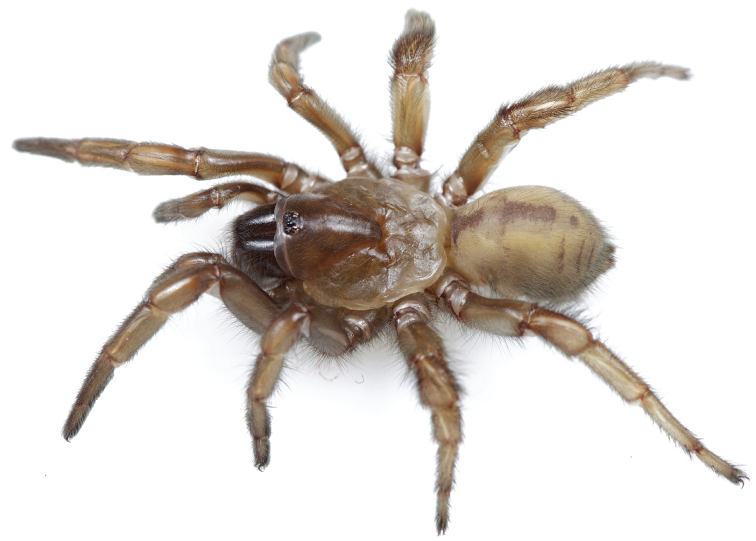
Live photograph, Aptostichus simus from Monterey County (AUMS022).